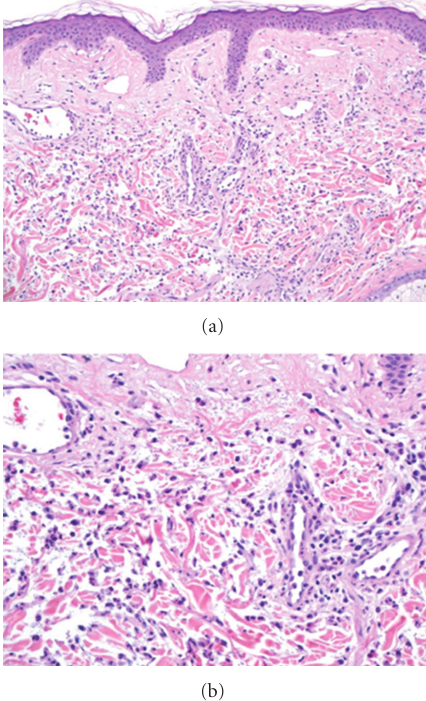
Figure 2: (a) Low magnification showing a di ff use dermal infiltrate of neutrophils accompanied by leukocytoclastic debris. (b) High magnification highlighting the